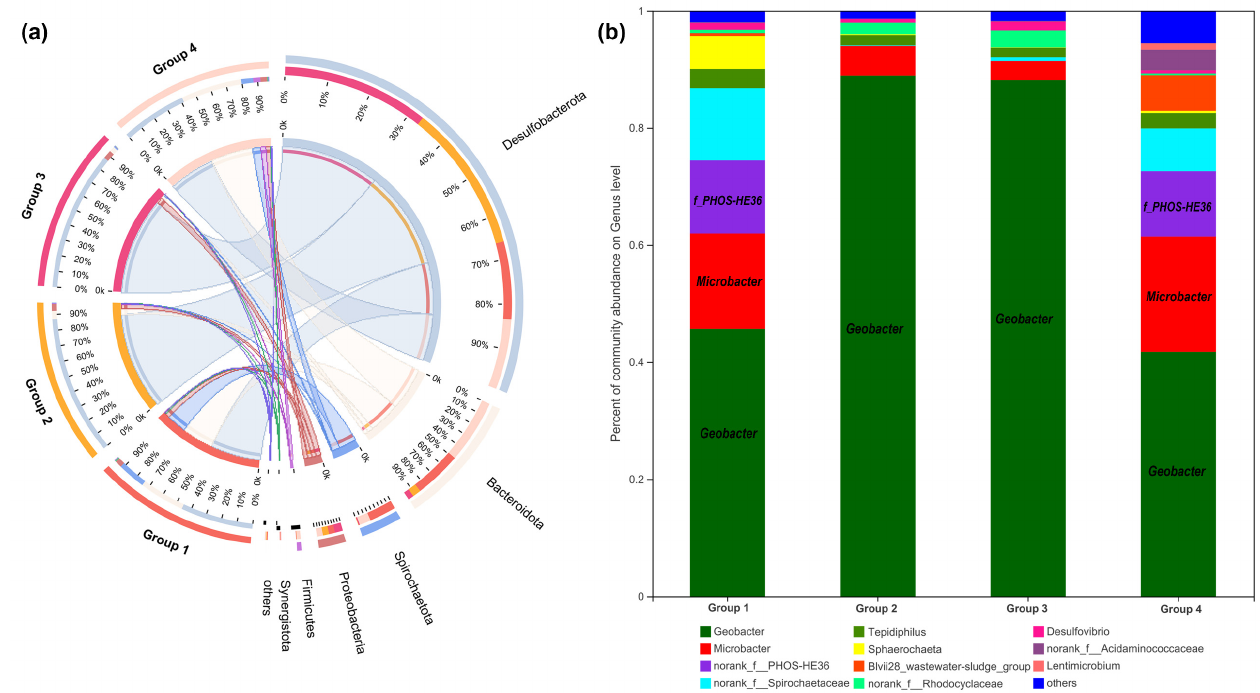
Figure 7. Microbial community analysis of anode biofilms in different groups. The relative abundance of microbial community compositions at the phylum ( a ), and genus level ( b ), respectively.